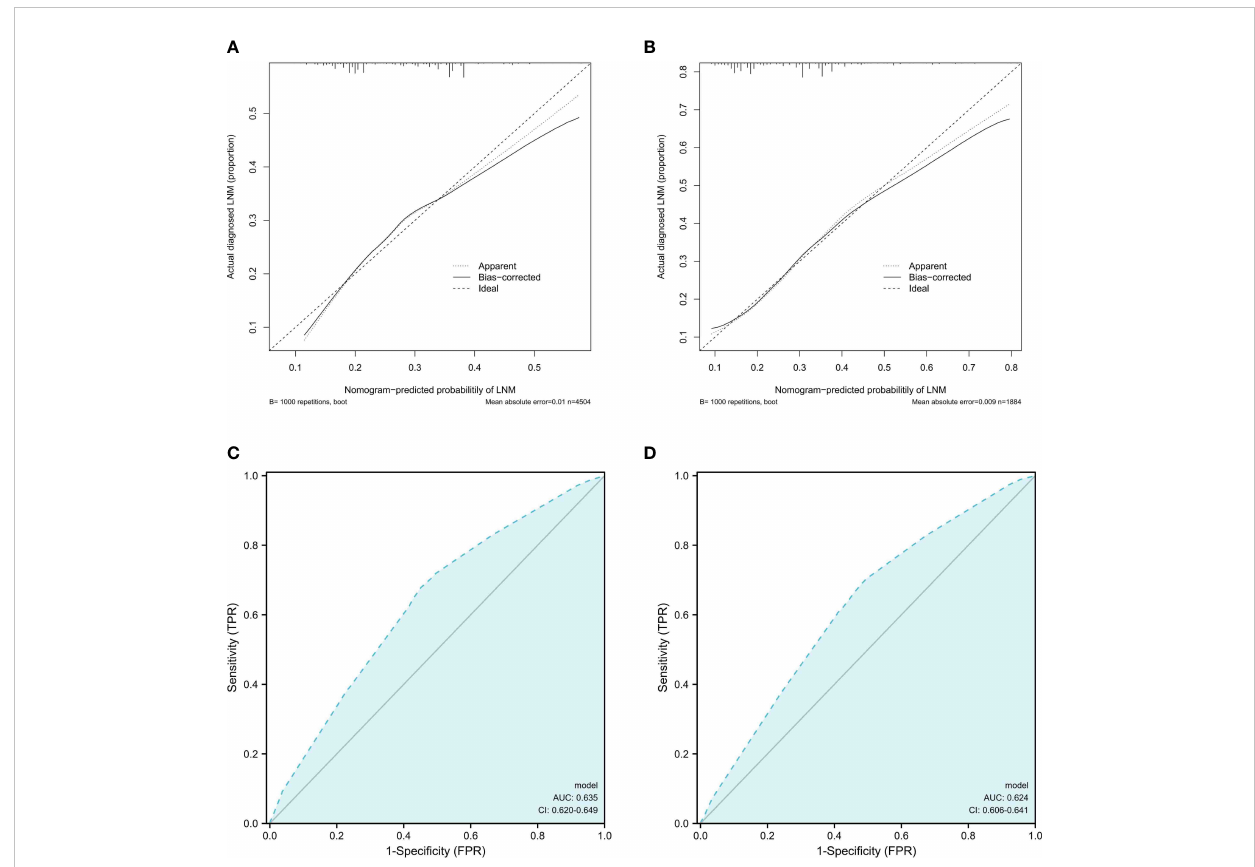
FIGURE 5 Calibration curves and ROC curves analysis. (A, B) .Calibration curves for LNM rates predicted by nomogram for training and validation cohorts (C, D) . Receiver operating characteristic (ROC) curves of the nomogram of LNM; The AUC values of the ROC curve predicted LNM rates for the nomogram in the training cohort, and validation cohort.